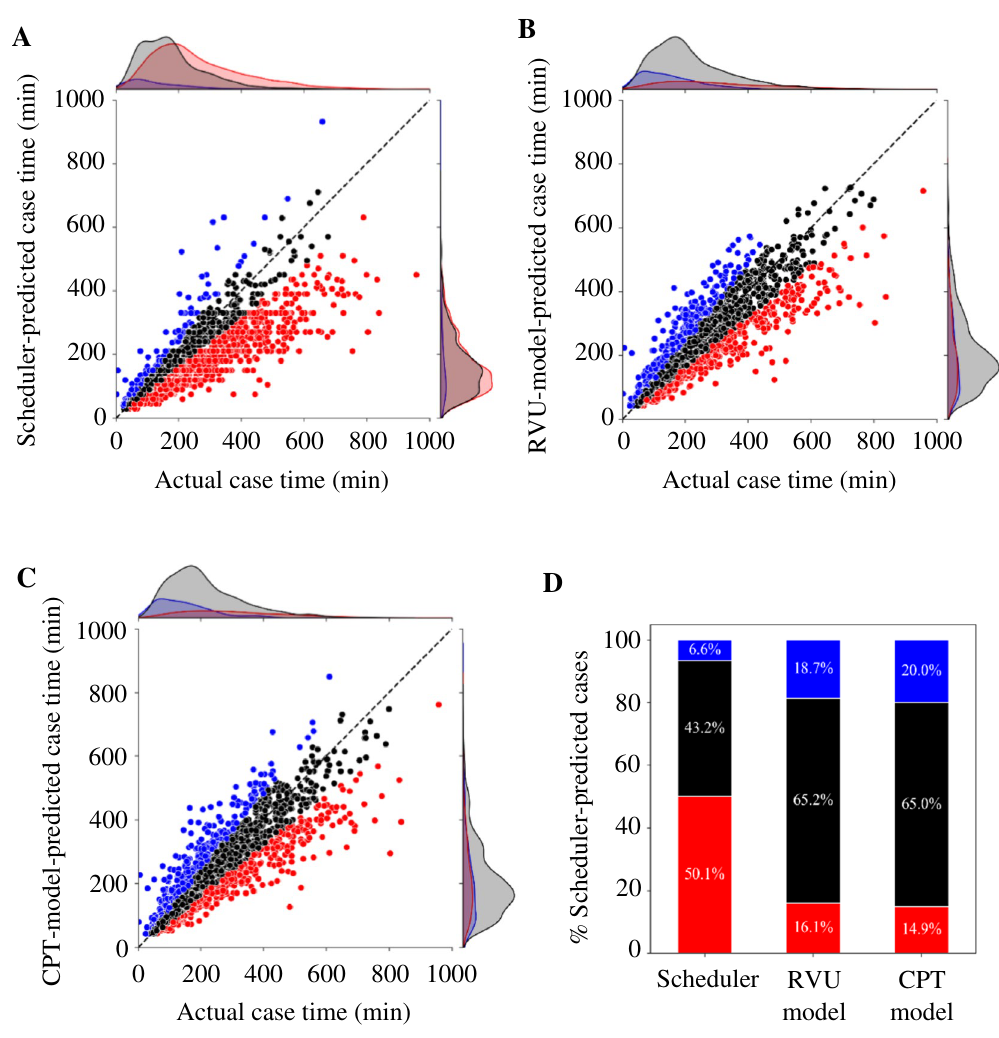
Figure 2. Overview of the models and the scheduler performance. ( A ) Distribution of the actual and the scheduler-predicted case time in minutes, ( B ) distribution of the actual and the RVU-model-predicted case time in minutes, ( C ) distribution of the actual and the CPT-model-predicted case time in minutes, ( D) percentage of cases predicted under, over, and on-time. Predicted case time within 20%, and > 20% under or over the actual case time are depicted in black, red, and blue, respectively.